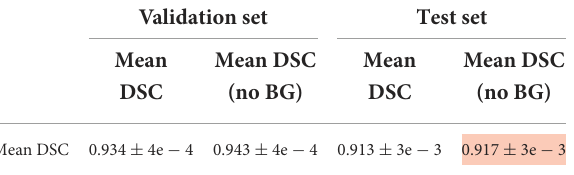
TABLE 1 Mean DSC for all nine tissue regions, averaged over four runs, computed on both the validation set and the held-out test set. Validation